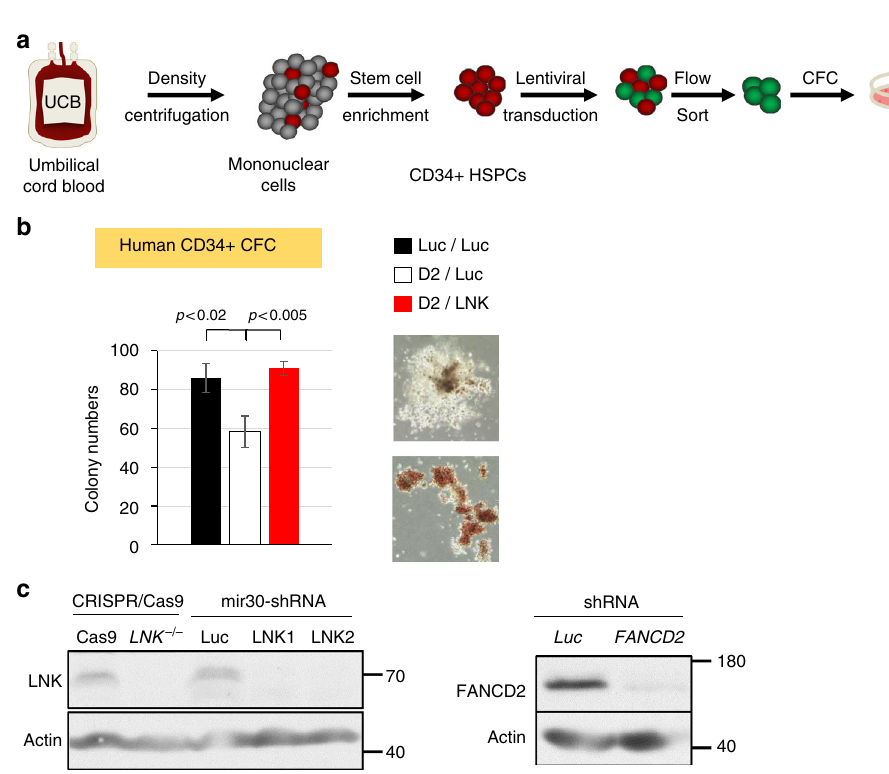
Fig. 7 LNK depletion restores FA-like human progenitor cells. a depicts a schematic overview of isolation of primary human HSPCs for lentiviral transduction followed by CFC assay. b UCB-derived CD34 + cells were sequentially infected with lentiviruses expressing shRNA to Luciferase (Luc) or FANCD2 (D2) with GFP marker, followed by shRNA to Luc or LNK with mCherry marker. GFP + mCherry + cells were then sorted and plated onto semi- solid methylcellulose media. Colony forming progenitor numbers are shown with a two-tailed Student's t -test. Representative data from two independent repeats are shown. c TF-1 cells with shRNA-mediated depletion of LNK or FANCD2 or CRISPR/Cas9-mediated depletion of LNK were analyzed for depletion ef fi ciency by western blot. Luc, luciferase. gRNA, guide